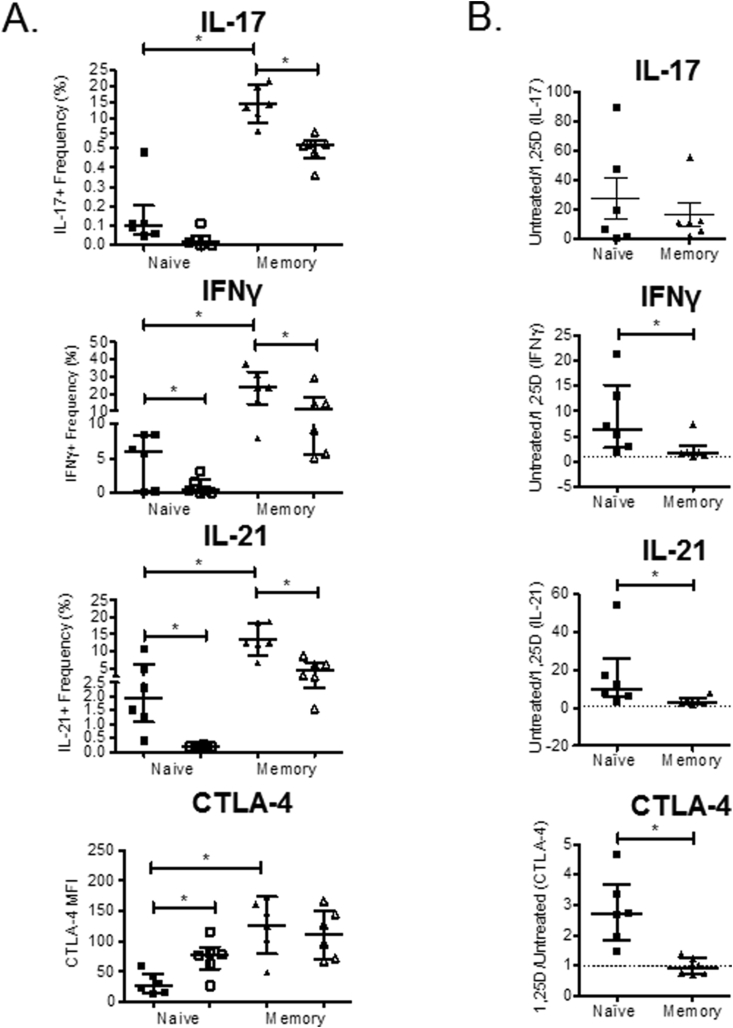
Effects of 1,25(OH)2D3are greater on naïve than memory T cells. Naive and memory CD4+ T cells were purified from the peripheral blood of healthy controls and stimulated with autologous monocytes and anti-CD3 in the presence or absence of 1,25(OH)2D3 (+1,25D). Frequency of cells expressing IL-17, IFNγ and IL-21 was quantified at seven days and expression of CTLA-4 and FoxP3 measured at four days by flow cytometry. (A) Frequencies of cytokine positive cells and CTLA-4 median fluorescence intensity (MFI) summarised for n = 6 donors for vehicle (closed symbols) and 1,25(OH)2D3 (+1,25D)-treated cells (open symbols). (B) The effect of 1,25(OH)2D3 on IL-17, IFNγ and IL-21 was compared for naïve and memory T cells by frequency of positive cells under untreated/1,25D conditions. A lower frequency limit of 0.001% was used for these calculations. 1,25(OH)2D3 effect on CTLA-4 was estimated by MFI under 1,25D/untreated conditions. Significant differences were tested using Wilcoxon matched pairs tests. ns = non-significant, * = P < 0.05, ** = P < 0.01, *** = P < 0.001.